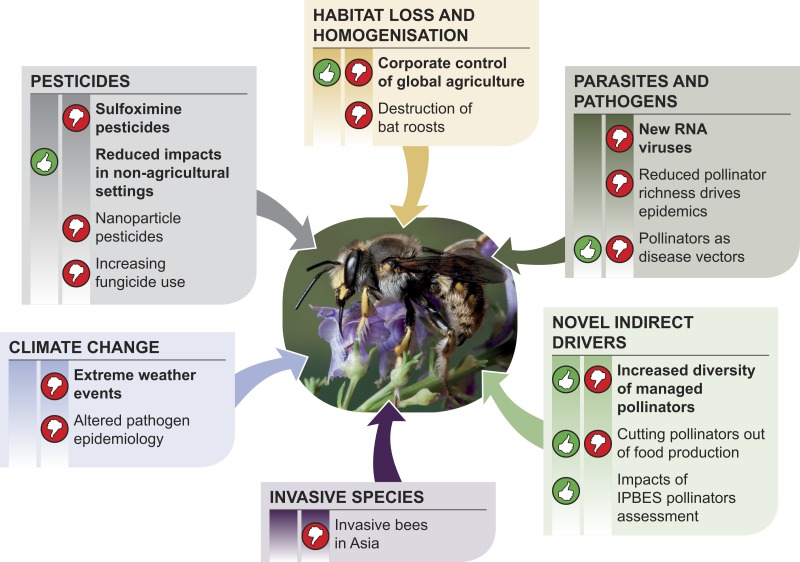
A schematic showing how the horizon scanning issues for pollinators map onto existing known drivers of pollinator decline, following Vanbergen & The Insect Pollinator Initiative (2013), and novel drivers with positive or negative opportunities.